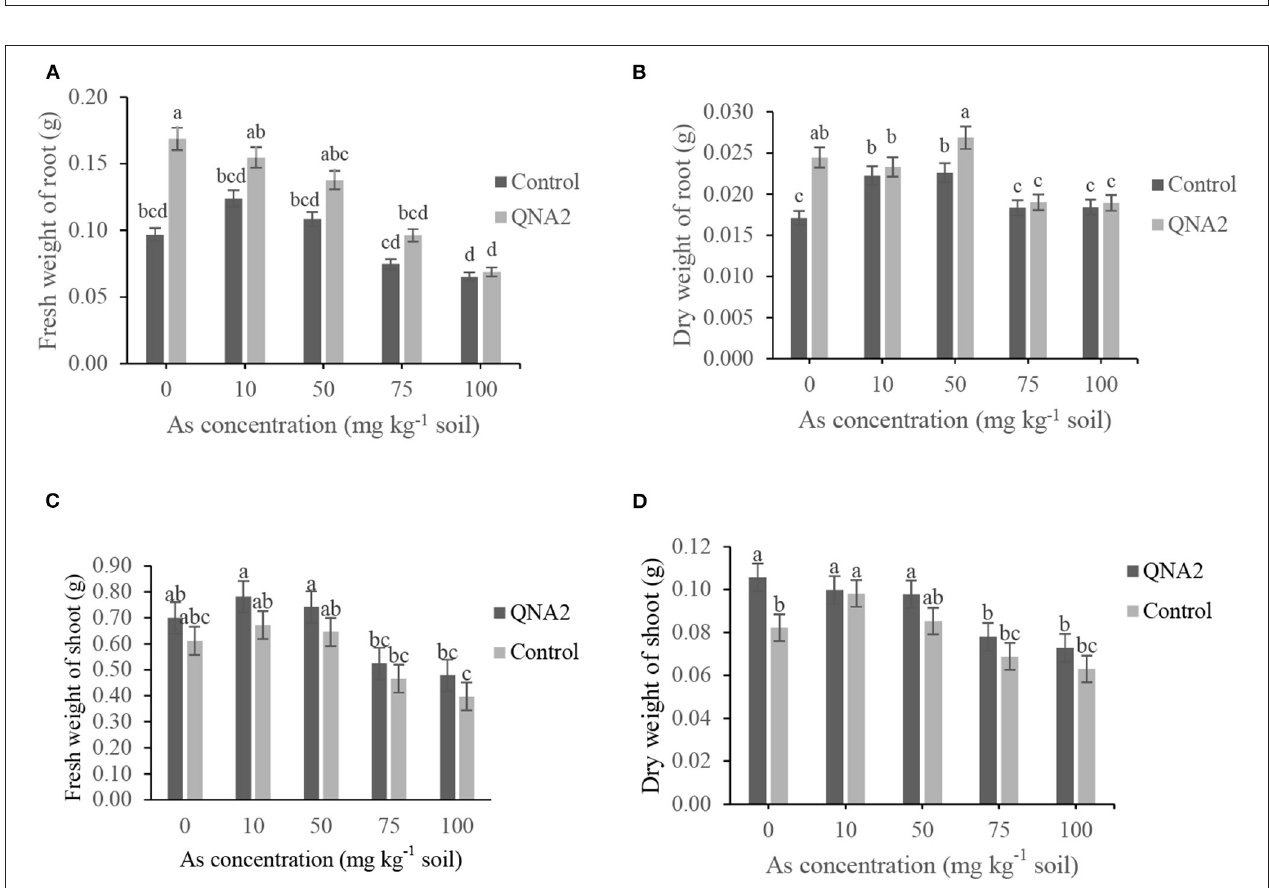
FIGURE 4 | Effect of different sodium arsenate concentrations on (A) the fresh weights of roots, (B) dry weights of roots (C) fresh weights shoot and (D) dry weights shoot biomass of alfalfa plants treated with Acinetobacter sp. QNA2. Data are the mean of three individual repetitions. Error bars indicate a standard error, and different letters above error bars represent significant differences based on a least significant difference (LSD) test (P = 0.05).